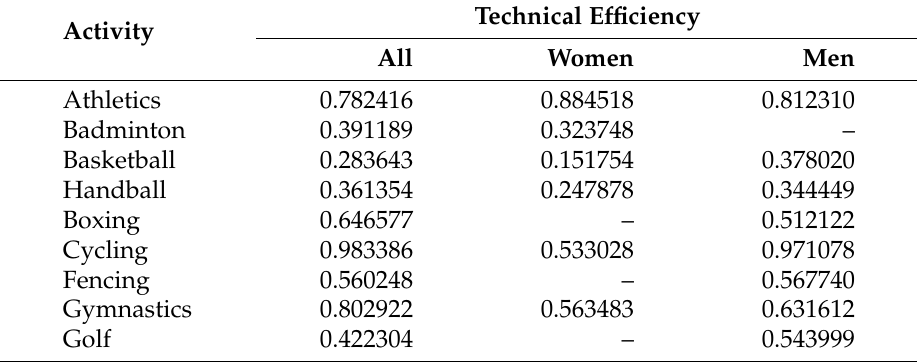
Table 6. Technical efficiency for all, women, and men (period 2005–2016) based on data provided in Table